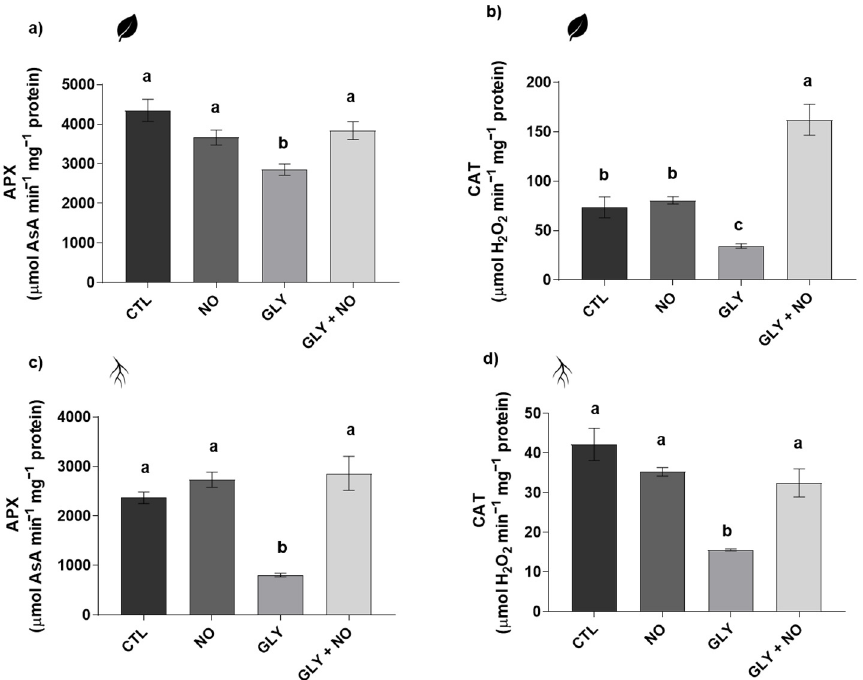
Figure 4. Activity of antioxidant enzymes of Solanum lycopersicum L. cv. Micro-Tom grown for 28 days in an artificial soil contaminated by GLY (10 mg kg − 1 ) and/or foliar sprayed with SNP (200 µM): ( a , c ) ascorbate peroxidase (APX) and ( b , d ) catalase (CAT). CTL—control plants, grown in the absence of GLY and foliar sprayed with dH 2 O once a week (black); NO—plants grown in the absence of GLY and foliar sprayed with SNP once a week (dark grey); GLY—plants grown in the presence of GLY (grey); GLY + NO—plants grown in the presence of GLY and weekly sprayed with SNP (light grey). Results are presented as mean ± standard deviation (SD) and result from the evaluation of at least three experimental replicates (n ≥ 3). Different letters above bars indicate significant differences between groups (CTL, NO, GLY and GLY + NO) at p ≤ 0.05, according to the one-way ANOVA followed by Tukey’s post hoc test.